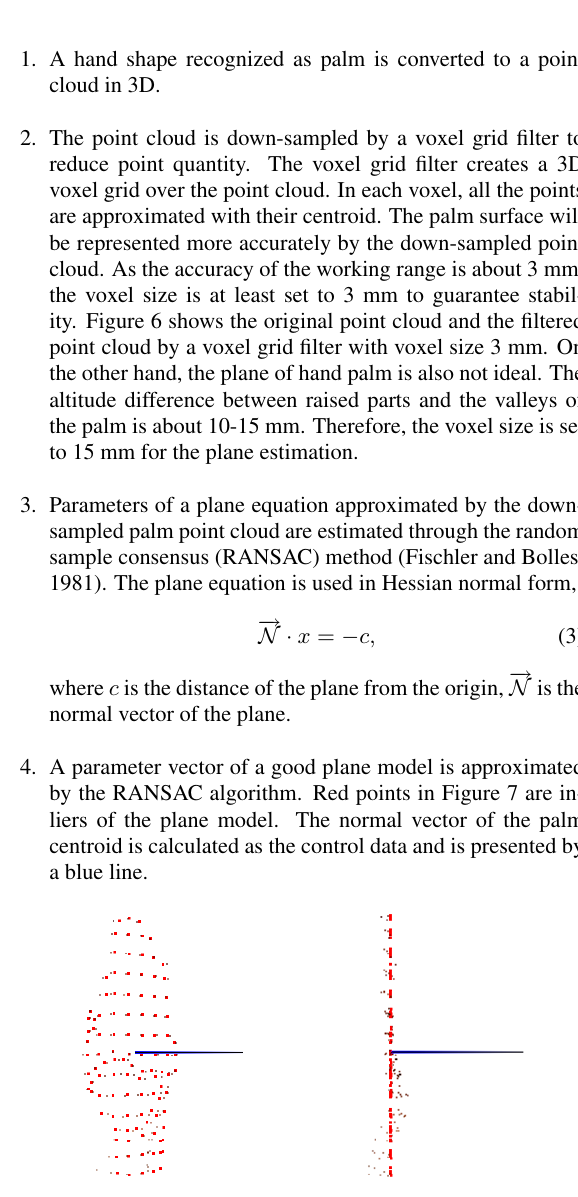
Figure 6: Reduction of points quantity by using a voxel grid filter Palm plane approximation To estimate the parameters of the plane, following processes are implemented: